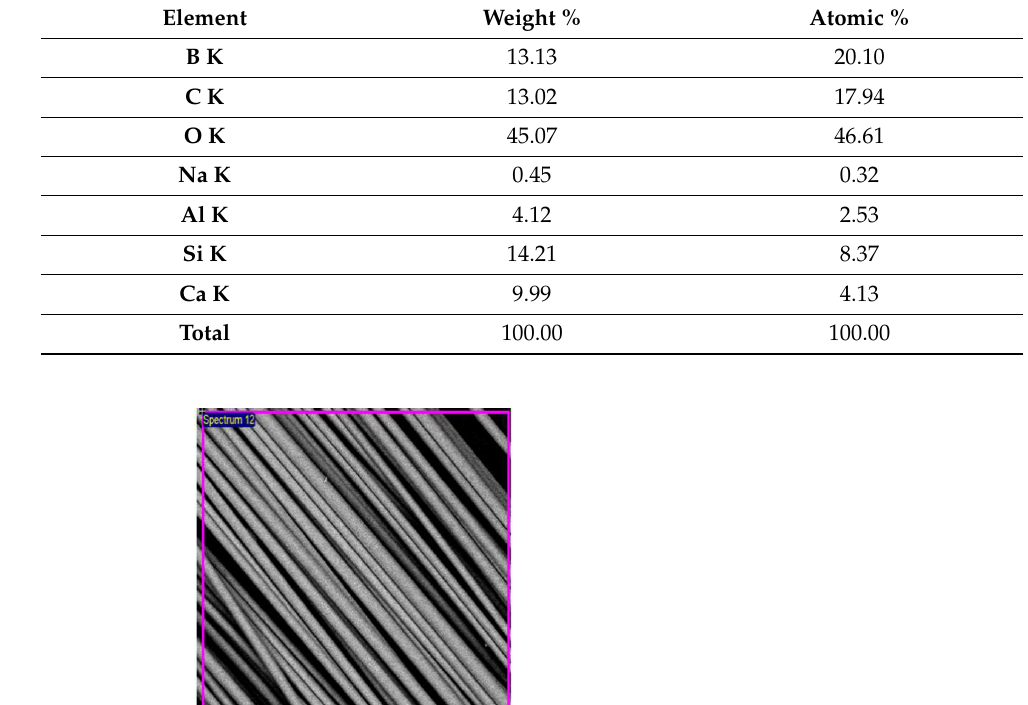
Table 1. EDX composition of E glass fiber.